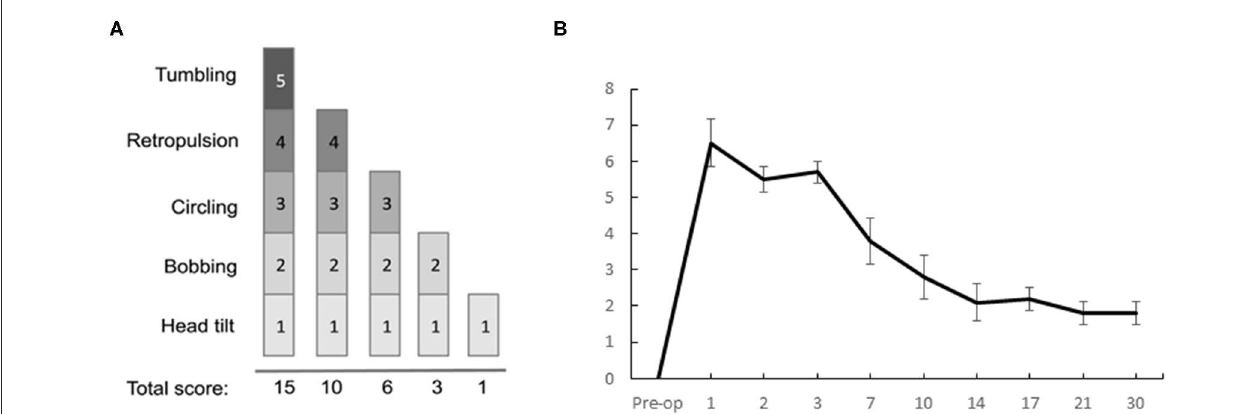
FIGURE 8 | Qualitative evaluation of the posturo-locomotor components of the vestibular syndrome. (A) Illustration of the evaluation grid used to conduct the analysis. (B) Results of the qualitative evaluation of the UVN group at the different delays of the study: we can observe a critical period when the disorders are at their peak from D1 to D3, then a period when the disorders gradually compensate each other, with a progressive decrease in the score from D7 to